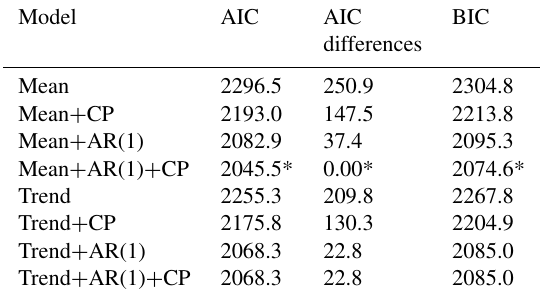
Table 2. Comparison of the eight models fitted to the AMOC– Ekman time series. The Akaike information criterion (AIC) and Bayesian information criterion (BIC) obtained for each model are presented. The most appropriate model from these information cri- terion is selected as the smallest and highlighted with a *. The AIC differences between each model fitted and the “best model” (with the smallest AIC) are also presented. The differences are all large ( > 10), indicating that there is no other model amongst those com- pared that fits the data reasonably well. Note that because no change points were detected under the Trend + AR(1) + CP model, the AIC and BIC are the same as the Trend + AR(1)